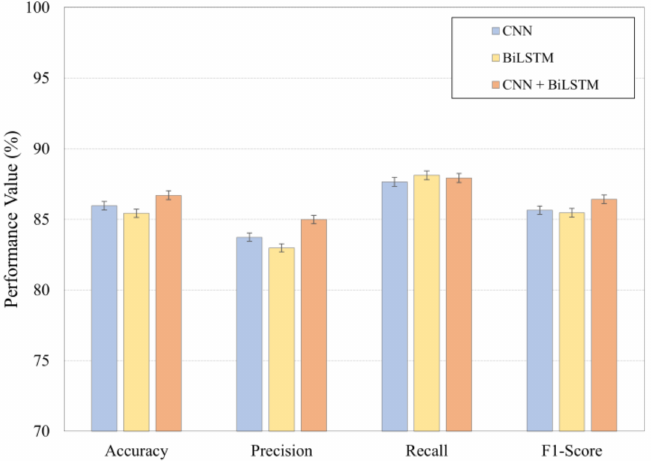
Figure 5. Performance comparison of classification